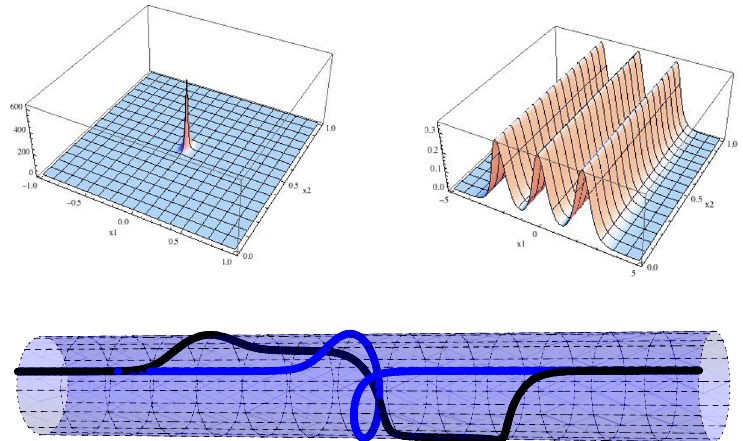
Figure 4 . When the moduli parameter of instanton is smaller than the scale set by the Ω F background, instanton looks like a single lump (first figure), and when the moduli parameter is large, it fractionates to N -pieces (second figure). Corresponding gauge holonomies for small and large instantons are also depicted, demonstrating fractionalization. For these solutions, ’t Hooft flux is set to zero. TQFT argument tells us that even when the instanton does not physically split to parts, it can still be viewed as a composite of N W = 1 /N fractional instantons. Figure borrowed from